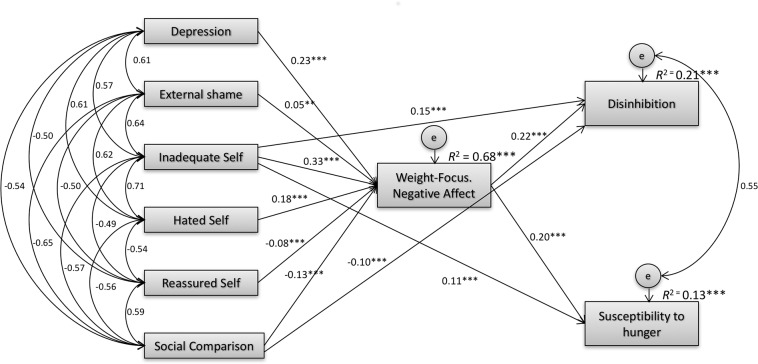
Path analysis for eating disinhibition and susceptibility to hunger.Mediation model with standardized estimates and R2 for weight-related negative affect, disinhibition and susceptibility to hunger. Model fit: χ2(8) = 15.134 (p = 0.057); CMIN/DF = 1.892; CFI = 0.999; TLI = 0.997; NFI = 0.999; RMSEA = 0.020, CI = 0.000 to 0.035, p = 1.000). When the effect of depressive symptoms was controlled for, the impact of shame, hated self and reassured self on disinhibition and susceptibility to hunger was fully mediated by their effect on weight-related negative affect. Inadequate self and negative social comparison predict higher disinhibition and susceptibility to hunger directly and partially through increased weight-related negative affect. Note: Depressive symptoms = Depression, Anxiety and Stress Scale-21 Depression subscale; External Shame = Weight-focused External shame Scale; Inadequate Self, Hated Self, Reassured Self = Weight-focused Self-Criticising/Self-Reassuring Scale subscales; Social Comparison = Weight-focused Social Comparison Scale; Weight-Focus. Negative Affect = Weight-focused Feelings Scale Negative Affect subscale; Disinhibition, Susceptibility to hunger = Three Factor Eating Questionnaire subscales.